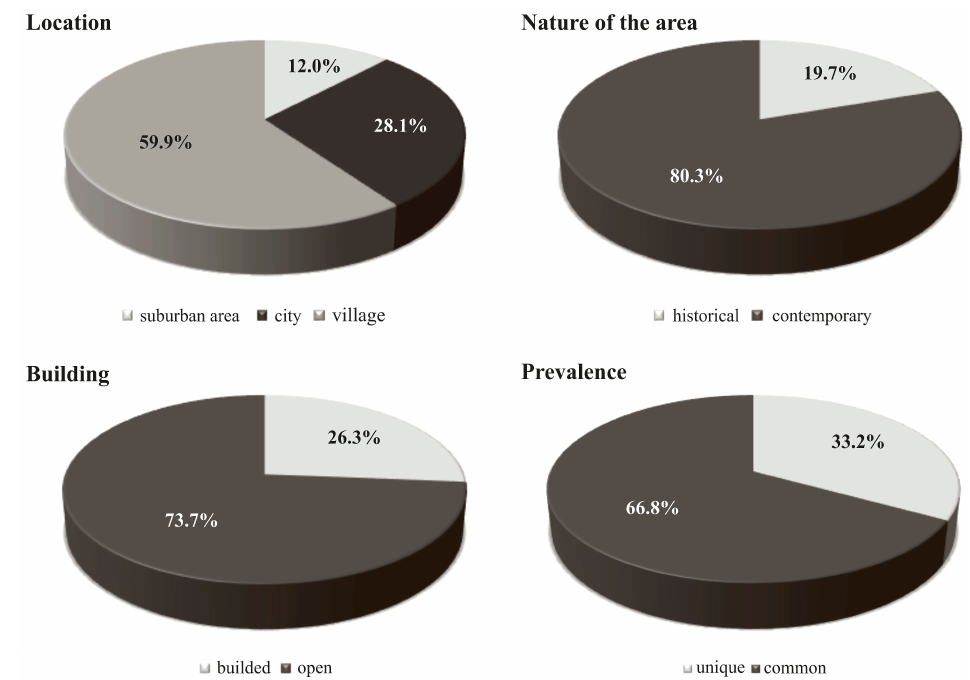
Figure 1. Characteristics of the harmonious landscape selected for description by the students (EnvEng and CivEng students combined, n = 244).